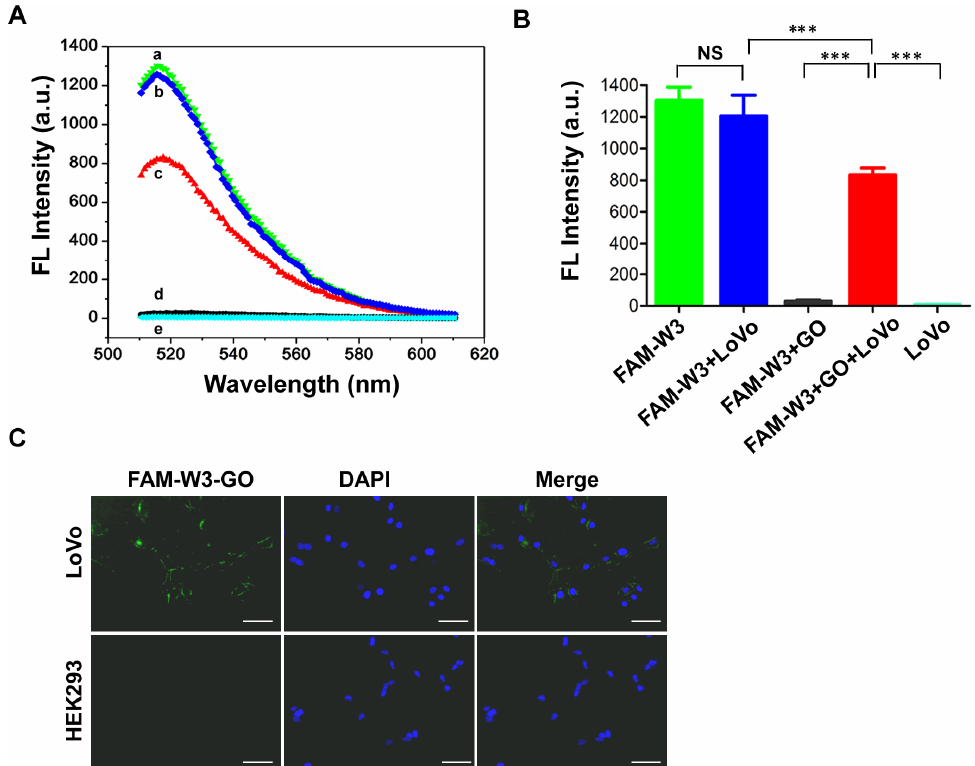
Figure 1. ( A ) The fluorescence spectra of FAM-W3 and LoVo cells at different conditions: (a) FAM-W3, (b) FAM-W3 + LoVo, (c) FAM-W3 + GO + LoVo, (d) FAM-W3 + GO, and (e) LoVo. ( B ) Statistical analysis of fluorescence spectra of FAM-W3 and LoVo cells at different conditions. NS, not significant; ***, p < 0.001. ( C ) Fluorescence images of LoVo and HEK293 cells incubated with FAM-W3-GO. The nuclei were stained with DAPI. Scale bar = 50 μ m.